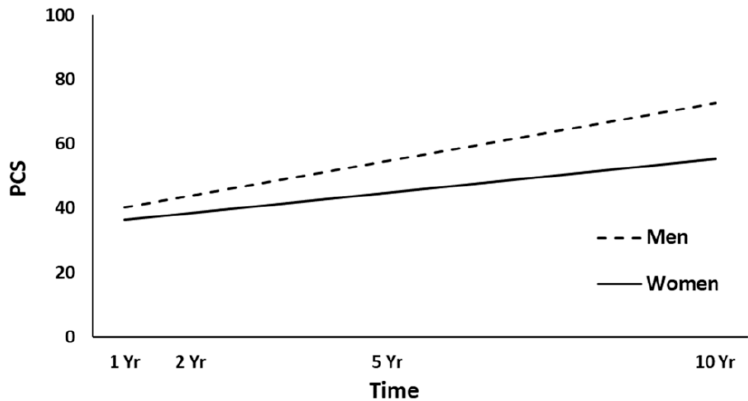
Figure 2. Main effect of gender on the physical health (PCS) trajectories. yr, year.